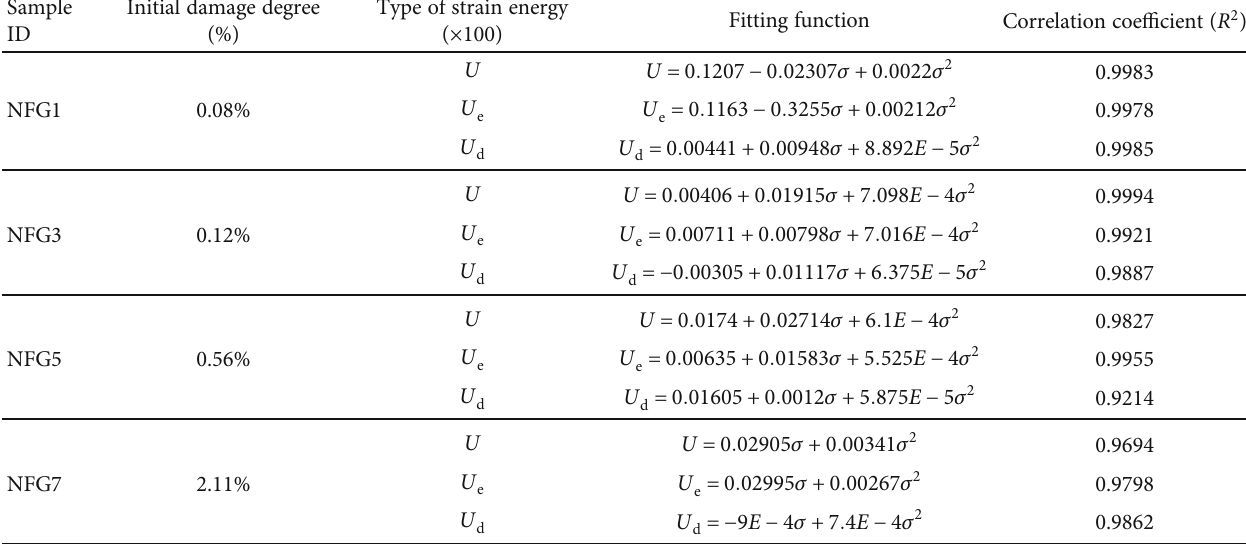
U e , d , and the upper stress